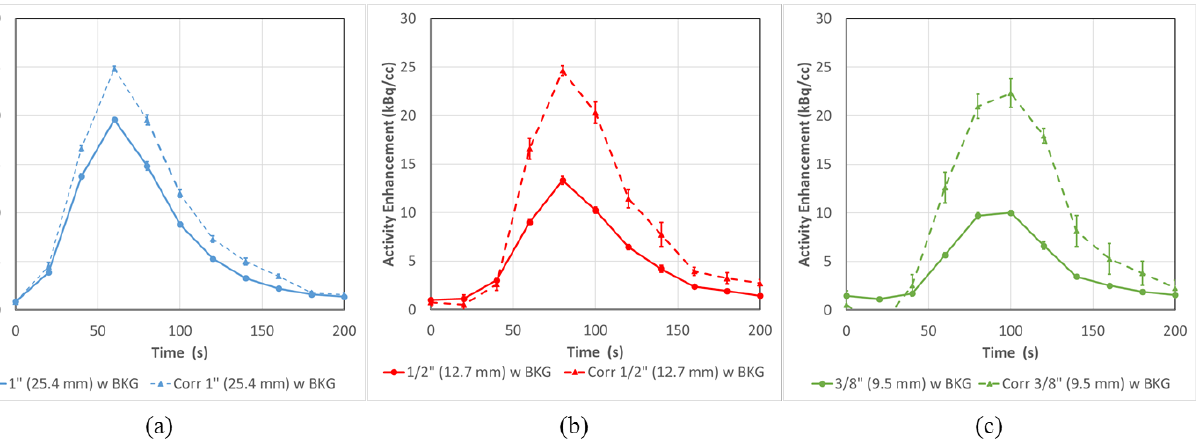
Figure 8. Corrected input functions at all tube sizes (a) 1” (25.4 mm), (b) ½” (12.7 mm) and (c) 3/8” (9.5 mm) with (dotted) and without (dashed) background are restored to various degrees in terms of both peak height and AUC. In the presence of background all three tubes have calculated AUC within 8 ± 9% of ground truth and peak heights within 9 ± 7% of averaged DCE-CT. In the absence of background these values are all somewhat reduced. PET-CT error bars represent the standard error from multiple ROI regions (n = 5). CT error bars represent the experimental range of replicate experiments (n = 2). By comparing the ground truth AUC with the image-derived AUC for the corrected PET-CTs, we observe a very good agreement, overall, for the three tubes in the presence of background (Figure 9 dotted lines), having calculated AUC within 5 ± 3%, 8 ± 9% and